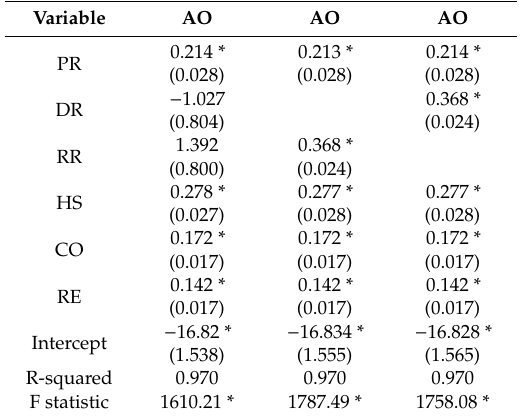
Table 7. Ordinal score of AO regressed on six category ordinal rankings.